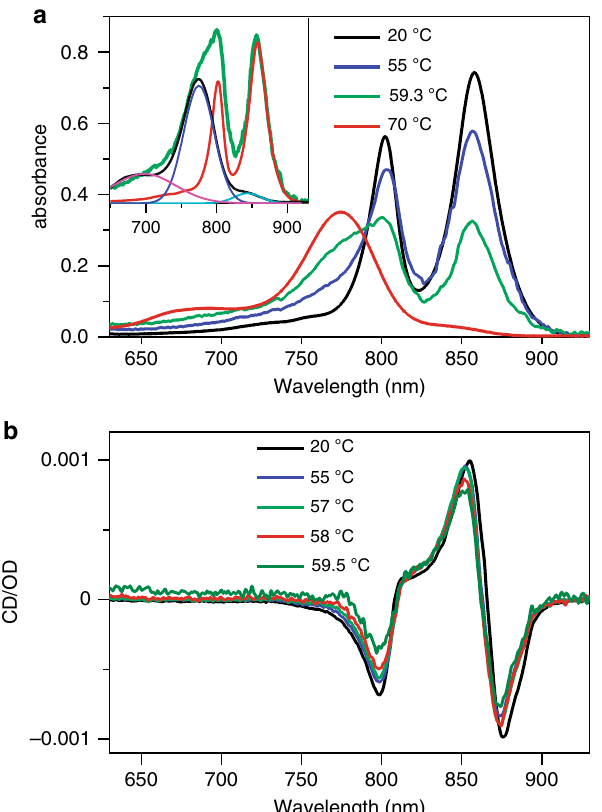
Fig. 3 Temperature dependence of absorption and normalized CD spectra. a Absorption spectra of LH2 complexes at various temperatures indicated. The inset shows a deconvolution of the absorption spectrum measured at 59.3 °C (green line) into intact LH2 (red line) and denatured temperature- induced product (black line) components. The shape of the denaturized component is further deconvoluted into three Gaussian curves corresponding to different forms of absorbing species: monomeric BChls (blue line), oxidized (magenta line), and partially disintegrated (cyan line) LH2 complexes. b CD spectra normalized to the B850 absorbance of LH2